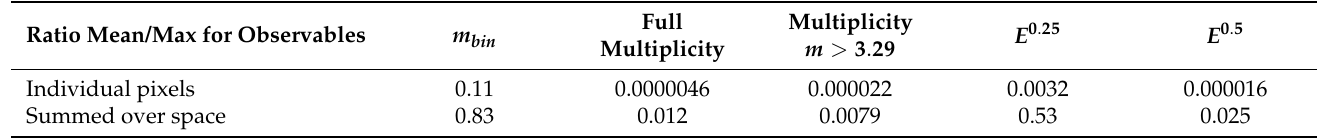
Figure 5. Comparisons of time dependence of four different measures of earthquake activity with m bin . The earthquakes marked are listed in Table 1. ( a ) Time dependence of Multiplicity > 3.29 events compared to m bin of Equation (1). ( b ) Time dependence of Multiplicity of all events compared to m bin of Equation (1) . ( c ) Time dependence of Energy 0.25 in fortnightly bins compared to m bin of Equation (1). Note the suppressed zero in plot. ( d ) Time dependence of Energy 0.25 in fortnightly bins compared to m bin of Equation (1). Table 2. Ratios of mean to the maximum of potential